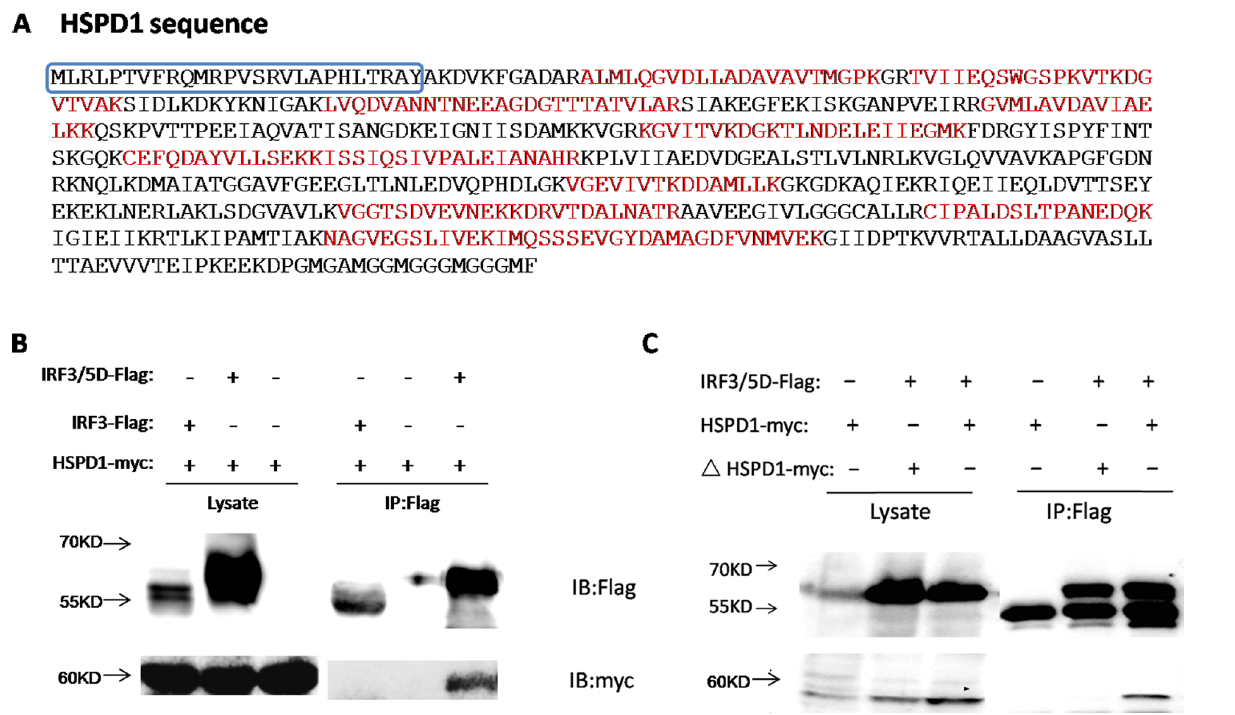
Fig. 1. Identification of HSPD1 as an interacting protein of IRF3. A. FLAG-tagged IRF3 was exogenously expressed in the HEK293Tcell line, and then the cells were activated by overexpression of RIG-IN or mock-transfected with the respective vector. The proteins were extracted and purified with anti- FLAG agarose gel. Next, the purified proteins were analyzed by LC-MS/MS. In comparison with the control sample, 53 peptides and 18 corresponding unique peptides of HSPD1 (coverage: 39.8%) indicated in red were identified in the induced samples. In the blue frame is mitochondrial transit peptide and D HSPD1 is lack of the mitochondrial transit peptide. B. Myc-tagged HSPD1 was co-expressed with FLAG-tag, FLAG-tagged IRF3, or FLAG-tagged IRF3/5D in HEK293T cells. The proteins were co-precipitated with anti-FLAG agarose gel and then probed with antibodies against Myc-tag or FLAG-tag. C. FLAG- tagged IRF3/5D was co-expressed with Myc-tagged HSPD1, Myc-tagged HSPD1 without the mitochondrial transit peptide or control vector in HEK293T cells. The proteins were co-precipitated with anti-FLAG agarose gel and then probed with antibodies against Myc-tag or